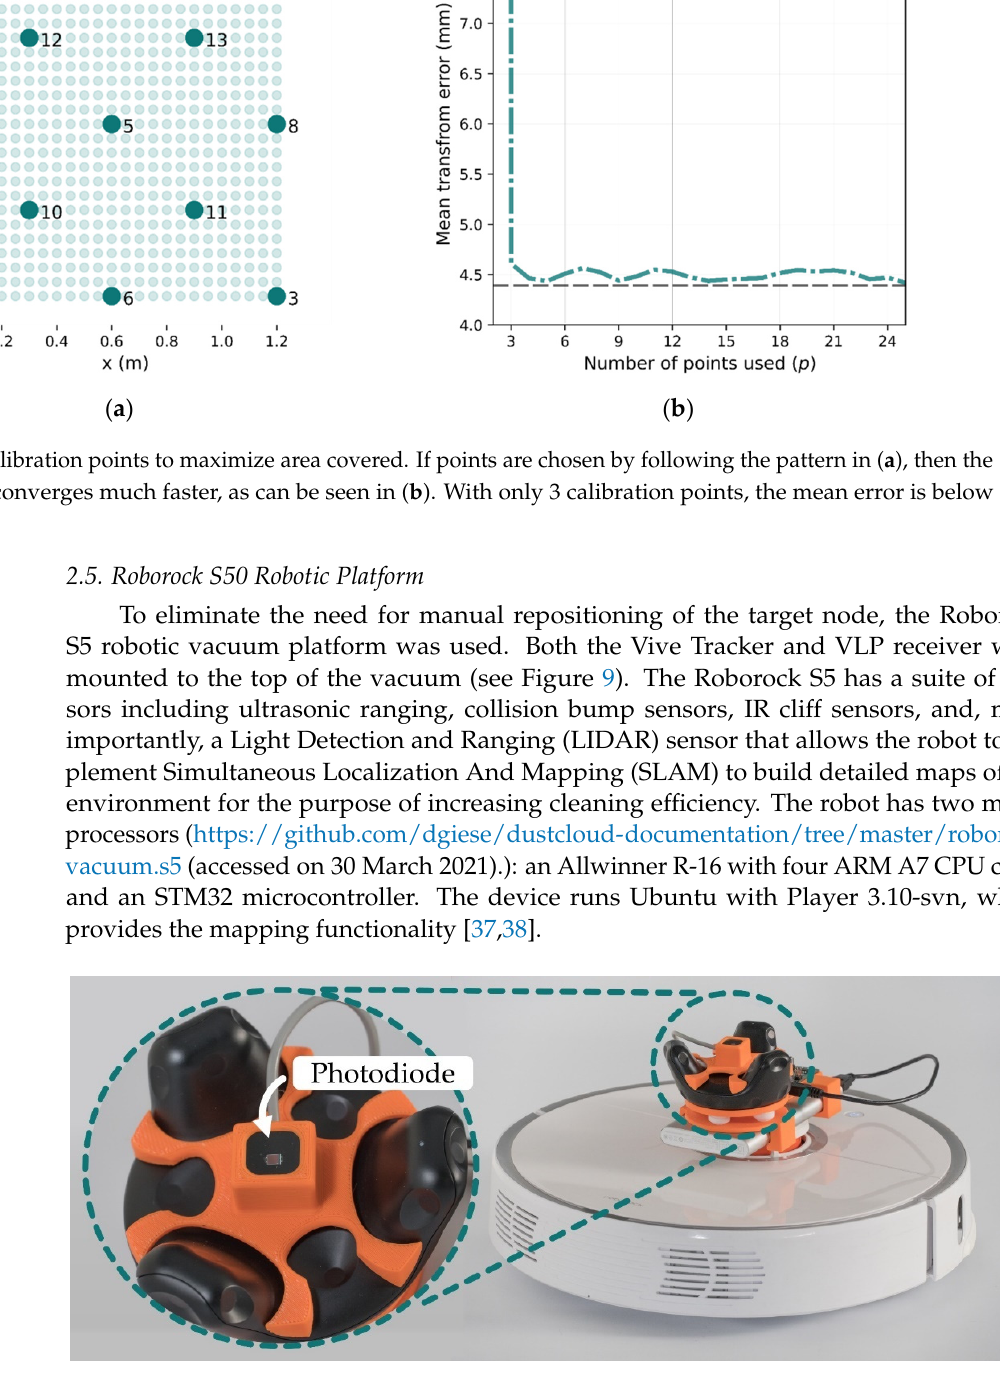
Figure 7. Dependence of transform accuracy on the number of calibration points. As more points are used, accuracy improves. The dashed grey line represents the ideal transform calculated using all 625 points. Using randomly chosen calibration points produces inconsistent results.